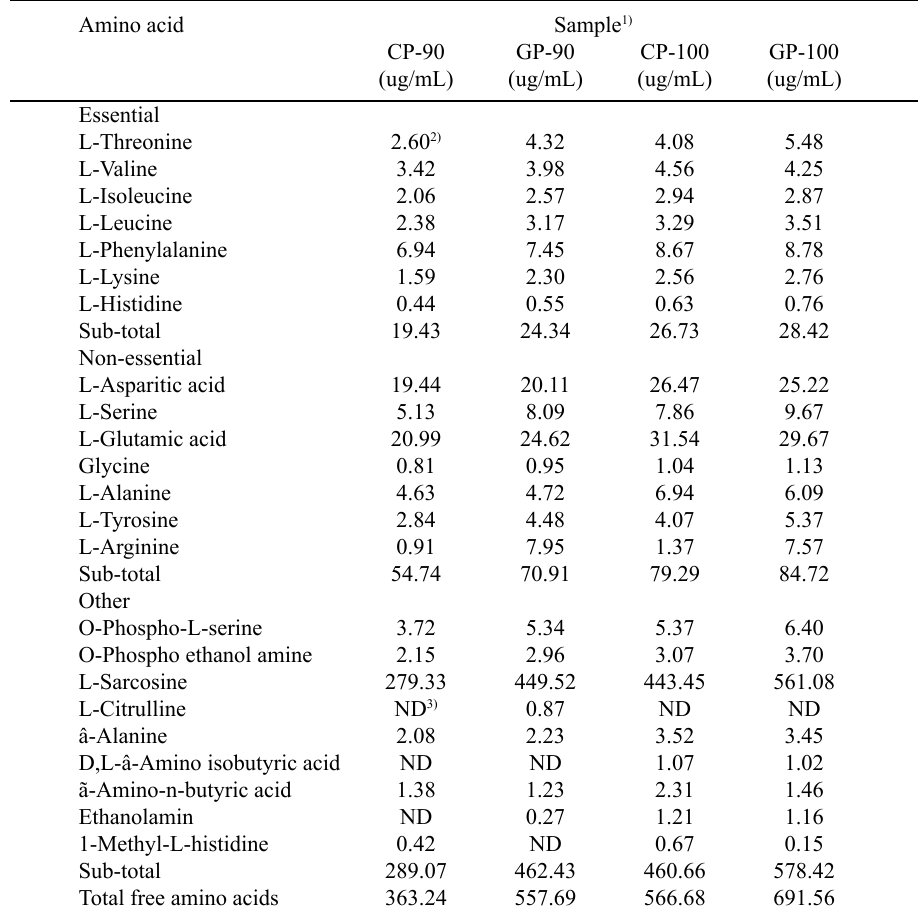
table 4. Free amino acid composition of